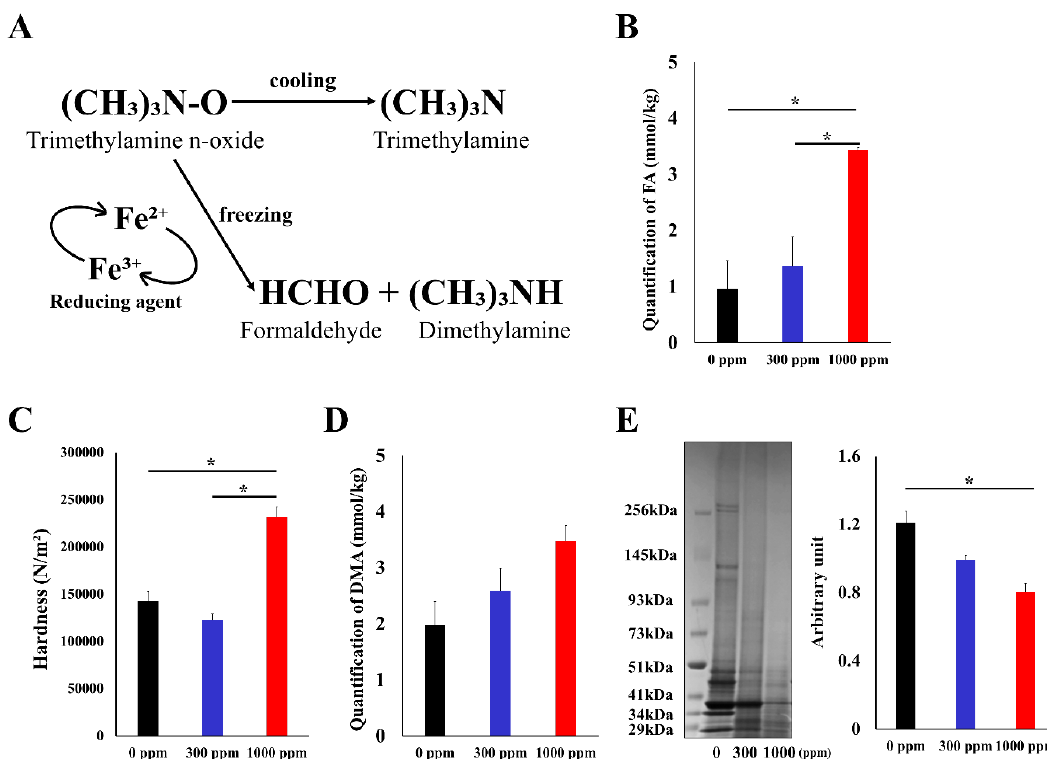
Figure 1. ( A ) Scheme of the production of dimethylamine (DMA) and formaldehyde (FA) from trimethylamine N-oxide (TMAO) in fish muscles. ( B ) Quantification of FA in three different fish